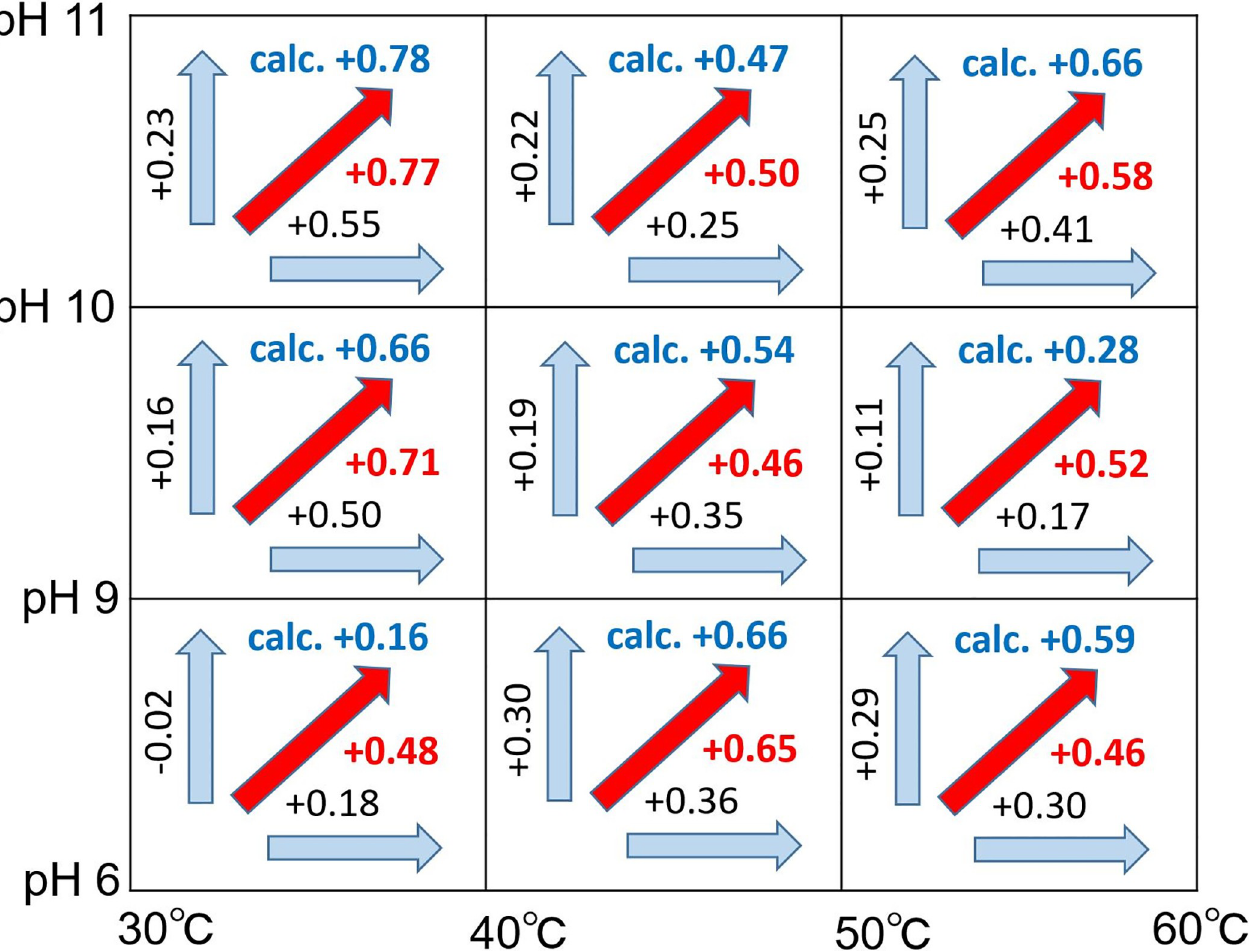
Fig 5. Determination of additive effect between the pH increase and temperature increase in hemoglobin cleaning: The increase in μ in pH is expressed as a vertical value, and the increase in μ r due to an increase in temperature is expressed as a horizontal value. In addition, the increase in μ due to an increase in the pH and temperature is expressed as a diagonal arrow. Moreover, additivity is confirmed if the calculated value (vertical value rl + horizontal value) is significantly close to the corresponding experimental value (value of red diagonal